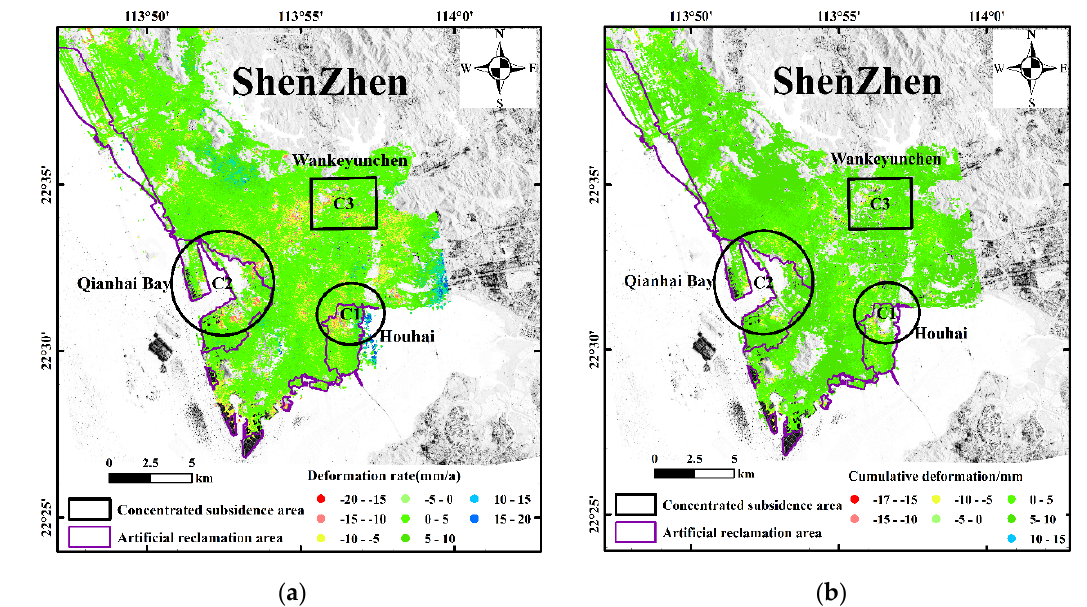
Figure 4. ( a ) Annual vertical subsidence rates based on TerraSAR-X images; ( b ) cumulative vertical subsidence rates based on TerraSAR-X images from August 2019 to May 2020. C1–C3, see next.